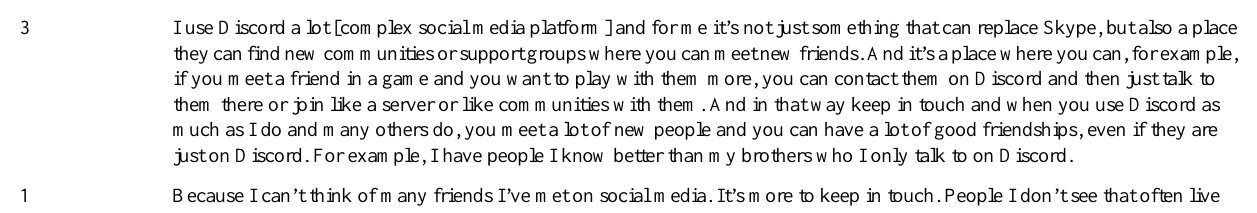
Table 1. Experiences of social interaction across current social interfaces, by theme and position. Exemplary quotesTheme and positions Establishing and maintaining social